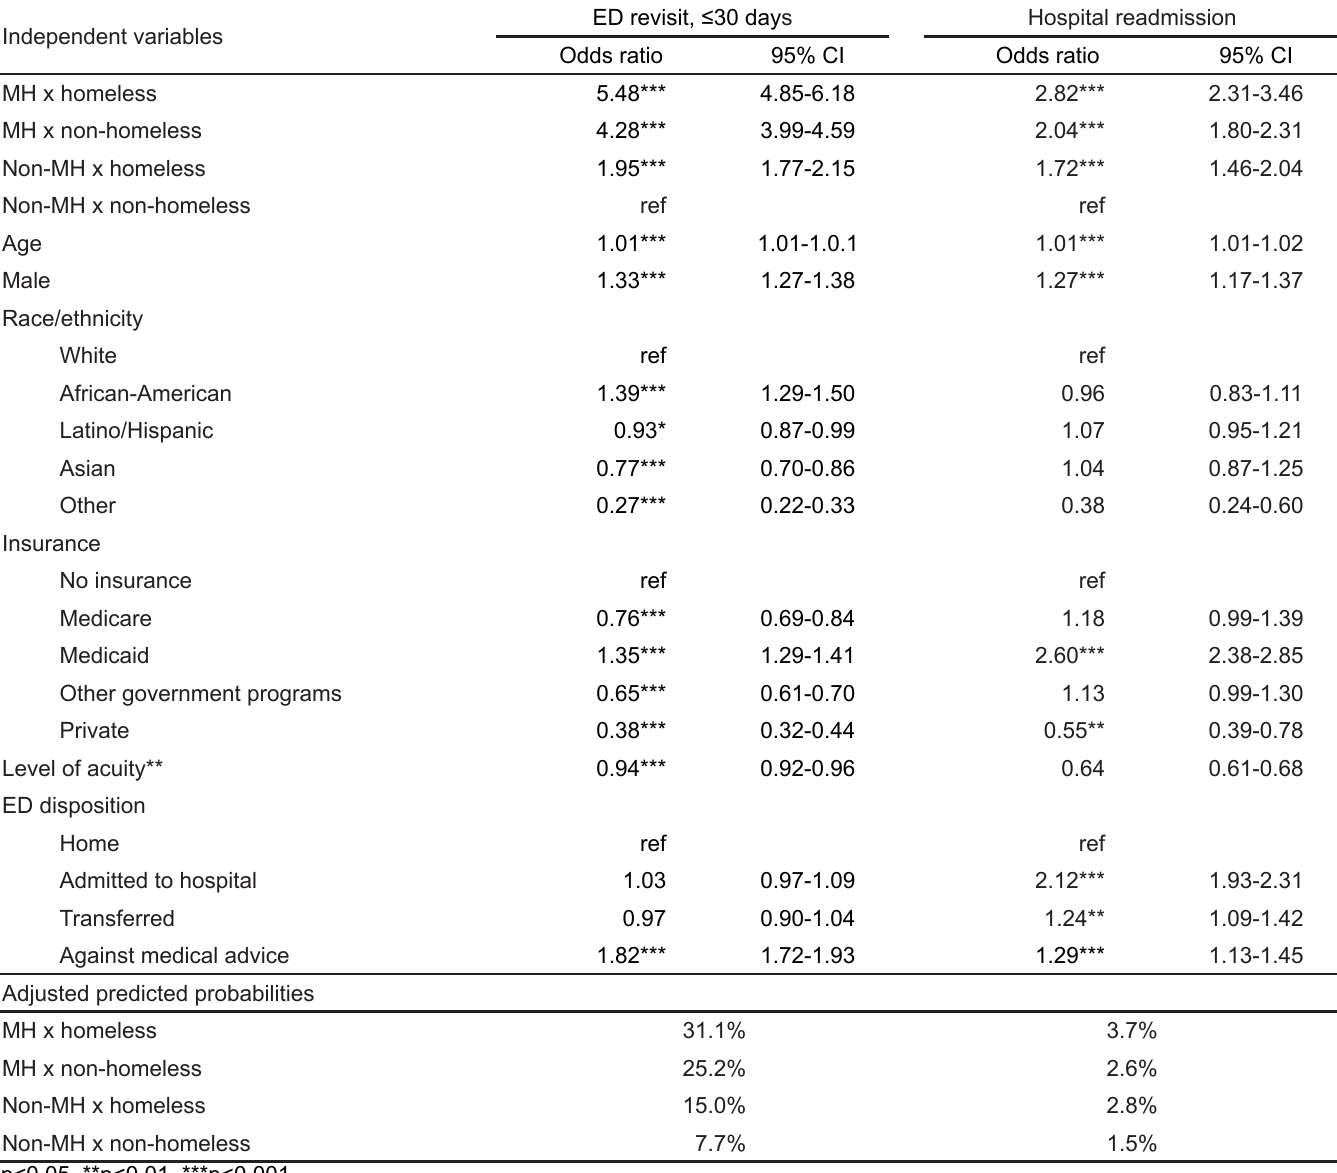
Table 2. Multilevel multivariate logistic regression analysis (n=92,307) showing interaction between homelessness and mental health